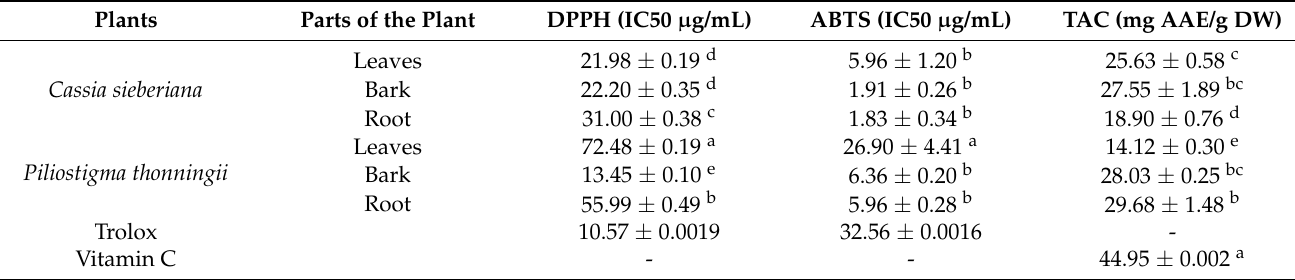
Table 2. Antioxidant activity of aqueous extracts of C. sieberiana and P. thonningii determined by DPPH, ABTS, and TAC